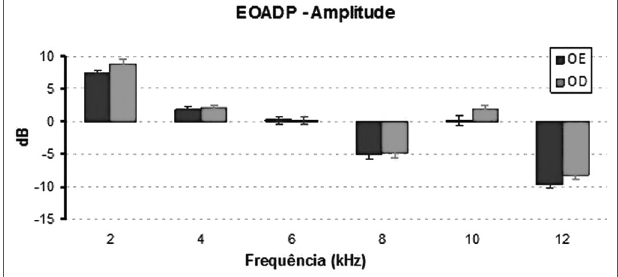
Figura 6. Média e desvio padrão das amplitudes das EOAPD registra- das para cada orelha em cada frequência. OE: Orelha esquerda; OD: Orelha direita. Teste ANOVA, p = 0,017.